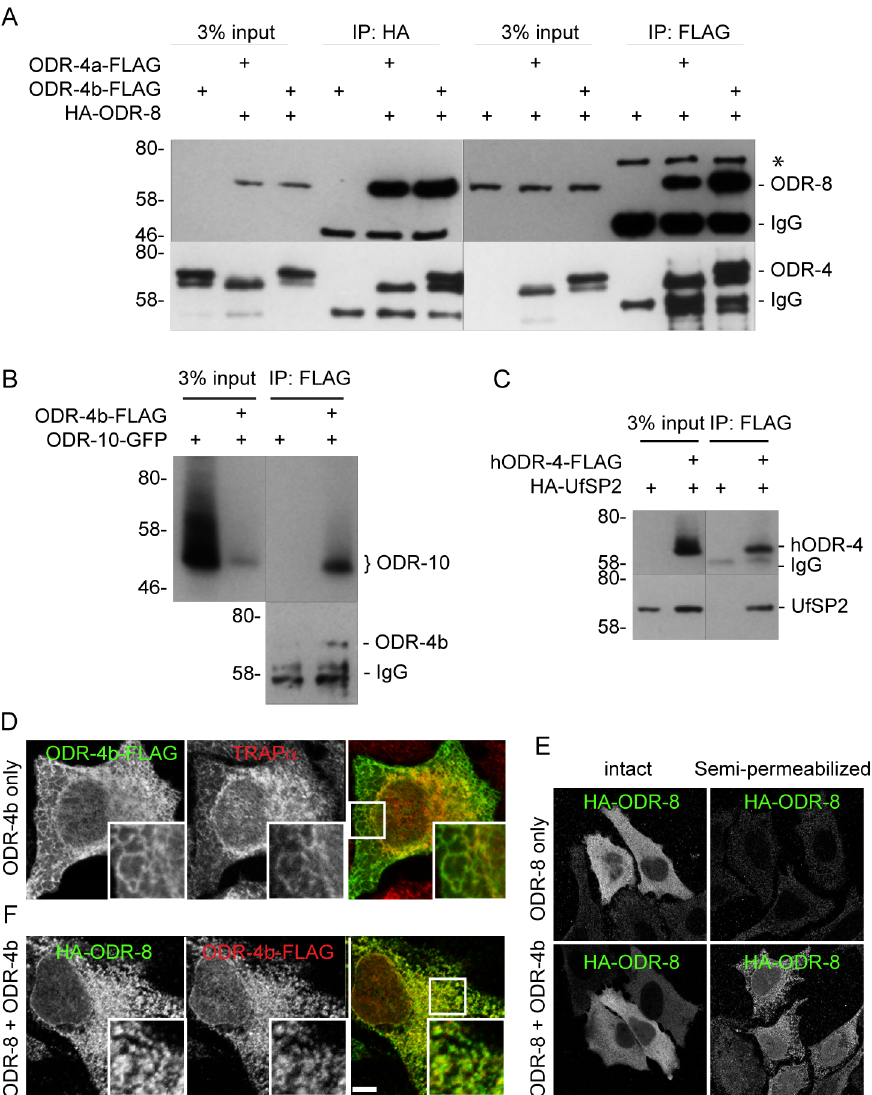
Figure 8. ODR-4, ODR-8 and ODR-10 form a complex at the ER. (A) HEK293 cells were co-transfected with ODR-4a-Flag, ODR-4b-FLAG and HA-ODR-8, and cell lysates were subjected to immunoprecipitation using indicated antibodies. The resulting precipitates were examined by immunoblot analysis with mouse anti-FLAG and mouse anti-HA antibodies. The asterisk indicates a non-specific band. (B) HEK293 cells were co- transfected with ODR-10-GFP with or without ODR-4b-FLAG, and cells lysates were subjected to immunoprecipitation using mouse anti-HA and rabbit anti-GFP antibodies. (C) HEK293 cells were co-transfected with human ODR4-FLAG and human HA-UfSP2, and cell lysates were subjected to immunoprecipitation using a FLAG antibody. The resulting precipitates were examined by immunoblot analysis with mouse anti-FLAG and mouse anti-HA antibodies. (D) HeLa cells were transiently transfected with ODR-4b-FLAG for 3 days. After fixation, the cells were subjected to immunocytochemistry using mouse anti-Flag and rabbit anti-TRAP a antibodies. (E) HeLa cells co-transfected with HA-ODR-8 and ODR-4b-FLAG as in panel D. fixed, and stained using rabbit anti-Flag and mouse anti-HA antibodies. Bar, 5 m m. (F) HeLa cells were transiently transfected with HA-ODR-8 alone or with HA-ODR-8 and ODR-4b-FLAG and cultivated for 3 days. In the panel marked ‘semi-permeabilized’ cells were treated with digitonin for 5 min prior to fixation, whereas in the panel labeled ‘intact’ the digitonin in step was omitted. Immunocytochemistry was performed using rabbit anti-Flag and mouse anti-HA antibodies.